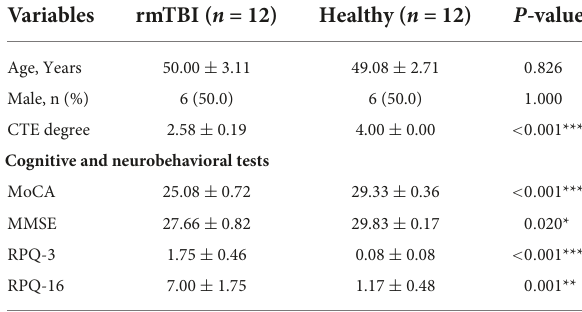
TABLE 1 Baseline characteristics of enrolled patients with rmTBI and control